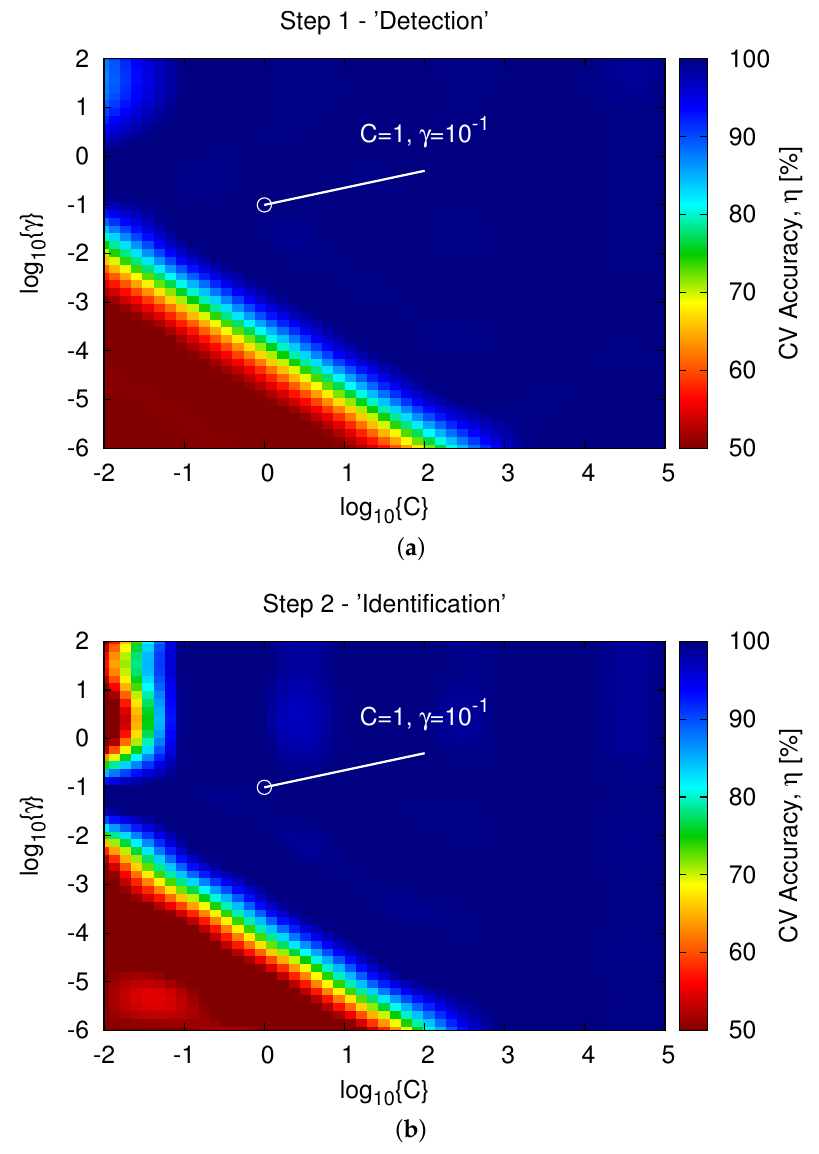
Figure 6. Experimental Assessment. ( V = 8, f 0 = 900 MHz, (cid:101) ε B = 41.8 ε 0 − j 0.97 S = 48.63 ε − j 1.28 , M = 500)—Behavior of the CV accuracy as a function of the SVM control (cid:101) ε 0 H 2 π f 0 parameters ( C , γ ) when dealing with ( a ) Step 1 (“Detection”) and ( b ) Step 2